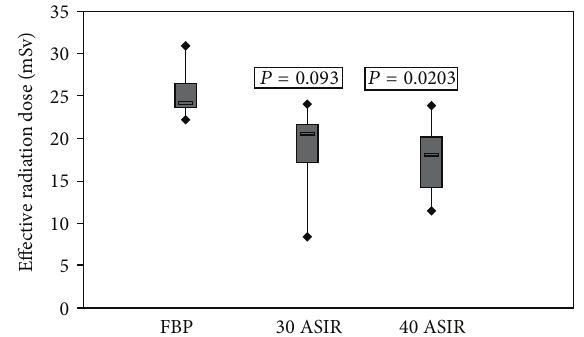
Figure 5: Dose reduction, comparison of three different CT proto- cols. The mean effective dose for the standard (FBP) protocol was 25.3±2.9 mSv, for IR 30 19.7±5.8 mSv, and 17.5±4.2 mSv for IR 40 protocol, that is, 22.1% effective dose reduction for IR 30 ( 𝑃 = 0.093 ) and 30.8% effective dose reduction for ASIR 40 ( 𝑃 = 0.0203 ). A 𝑃 value of less than 0.05 was considered a statistical